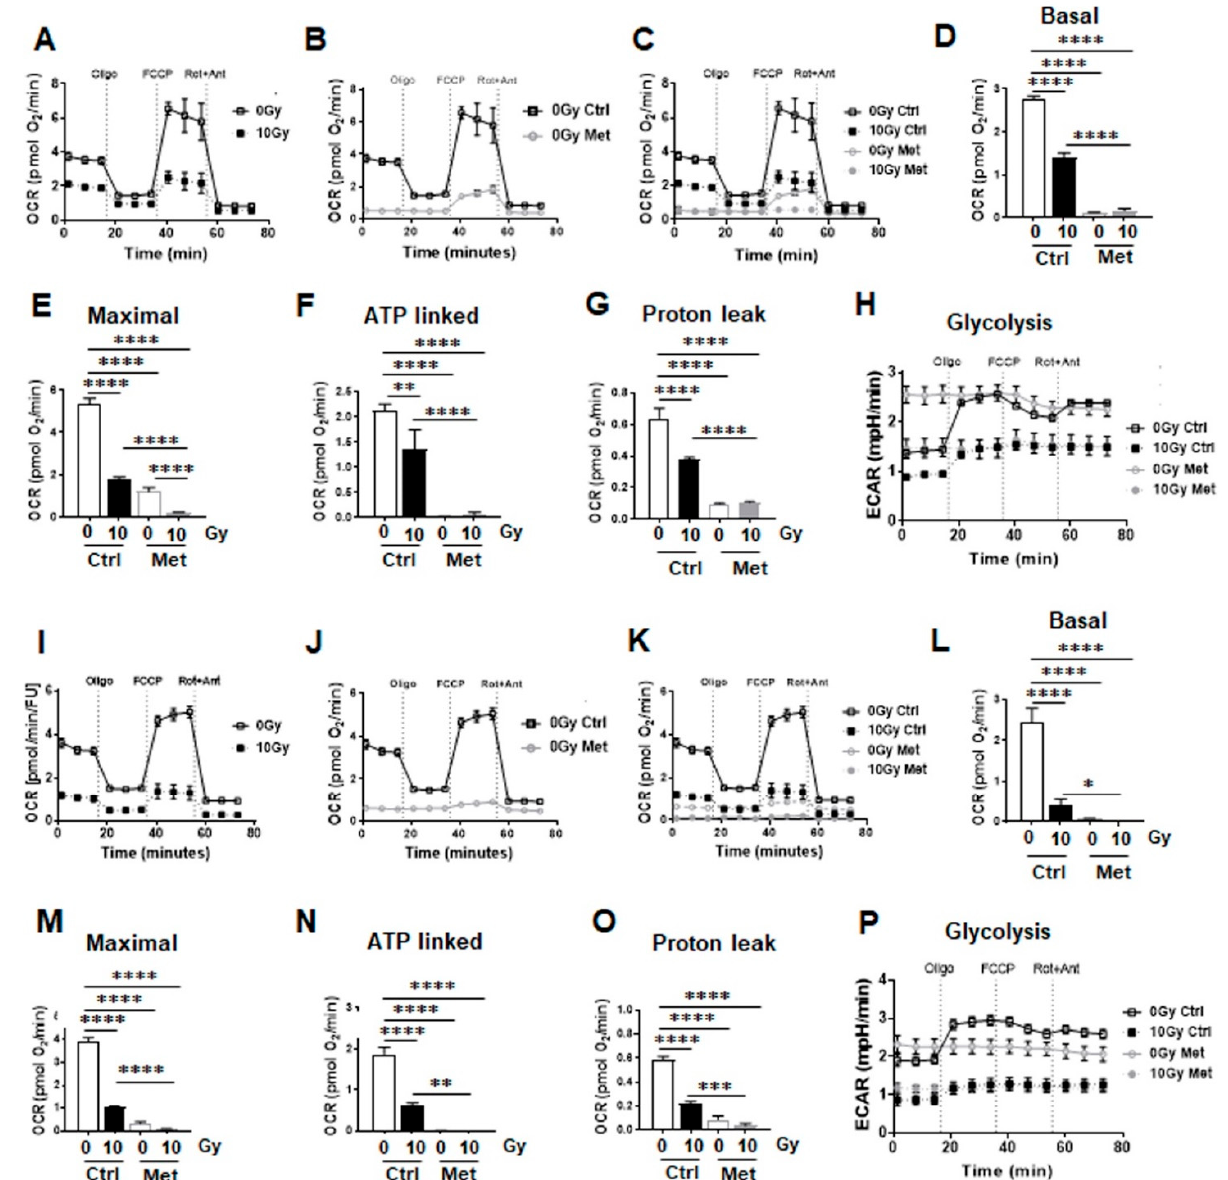
Figure 7. Metformin treatment reduces mitochondrial respiration in non-malignant epithelial lung cells. Extracellular flux analyses following (24 h after) metformin and RT treatment were performed in order to measure oxygen consumption rates (OCR) and extracellular acidification rates (ECAR) in BEAS-2B ( A – H ) and HSAEC1-KT ( I – P ) over time, while oligomycin (Oligo; 1 µM), FCCP (1 µM) and rotenone/ Antimycin A (Rot/Ant; 0.5 µM) were added at indicated time points. ( A , I ) OCR levels of control and irradiated lung epithelial cells are shown. ( B , J ) OCR levels of control and metformin treated lung epithelial cells are shown. ( C , K ) Decreases in OCR following the combined treatment are shown. ( D , L ) Basal respiration, ( E , M ) maximal respiration, ( F , N ) ATP production, and ( G , O ) proton leak were depicted in separate bar diagrams. ( H , P ) Respective ECAR measurement over time are shown. Data were summarized as mean values ± SD (measured in 4–7 replicates each). One of 3 independent experiments per epithelial cell line with similar results is shown. p -values indicate: * p ≤ 0.05, ** p ≤ 0.01, *** p ≤ 0.001, **** p ≤ 0.0001 by one-way ANOVA with Tukey’s multiple comparison